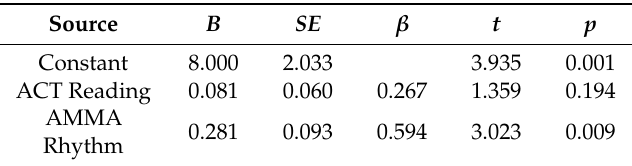
Table 1. Multiple regression coefficients. 1